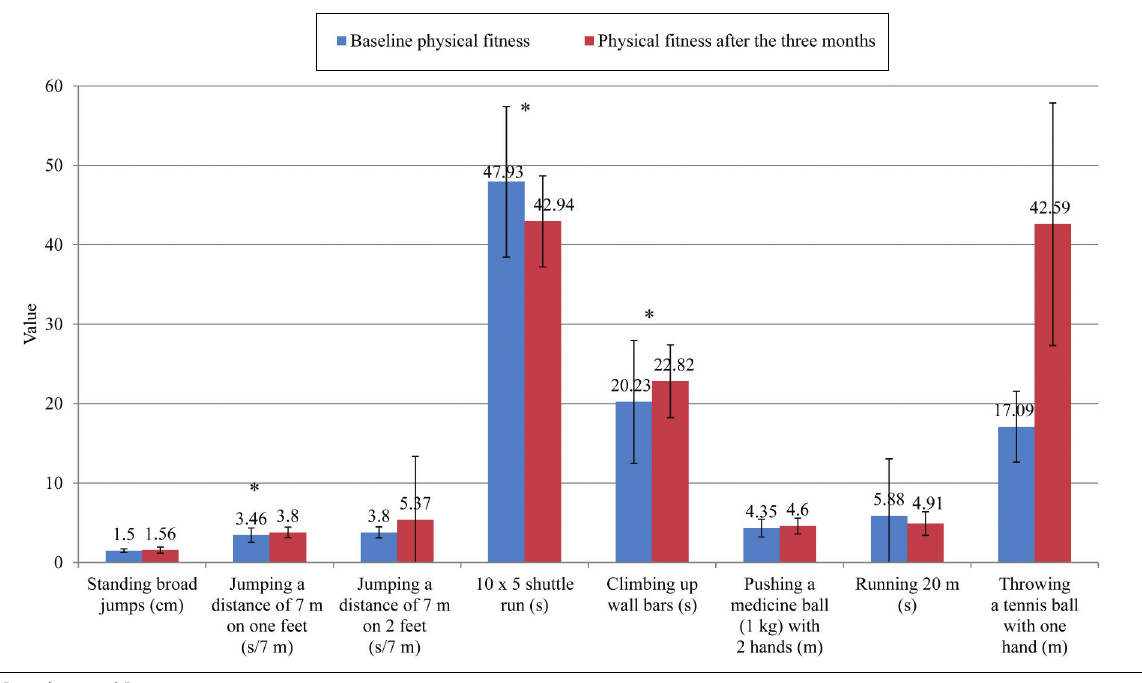
Note. * – p < Figure 4. Changes of physical fitness in three months in the experimental group of boys